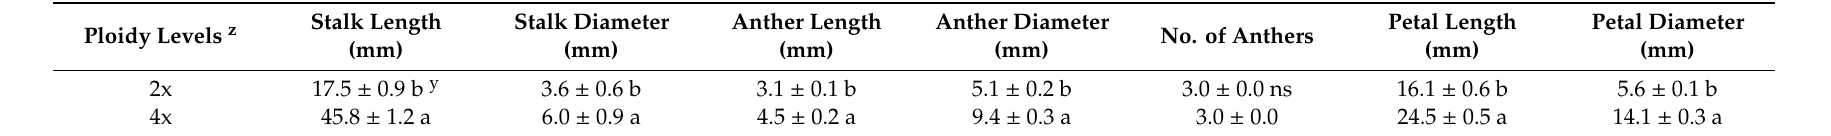
Table 5. Comparison of the staminate flower traits in the induced tetraploid with diploid pointed gourd plants. Ploidy Levels z